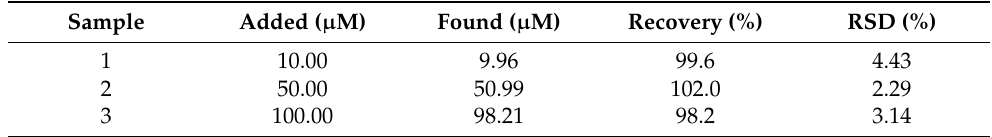
Table 3. Determination of DA in serum samples ( n = 3).